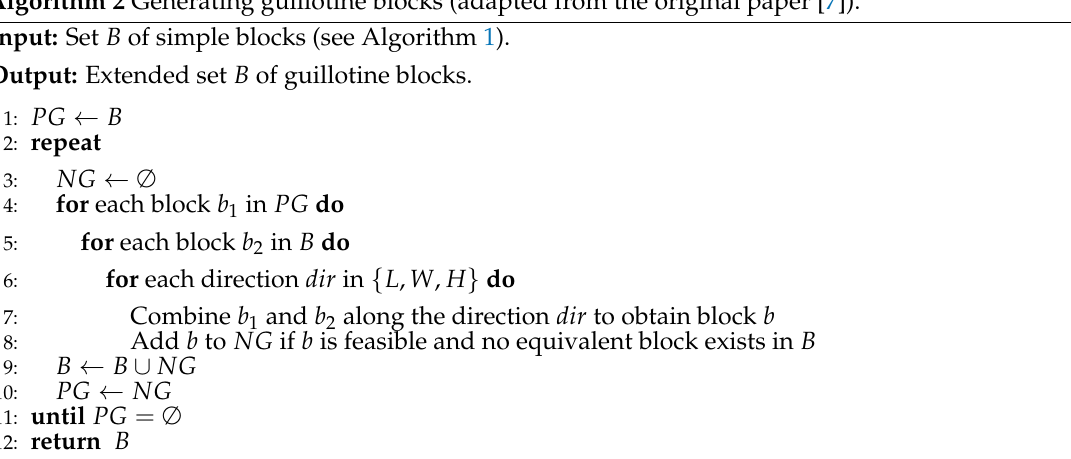
Figure 3. A guillotine block obtained from the combination of two simple blocks. Algorithm 2 Generating guillotine blocks (adapted from the original paper